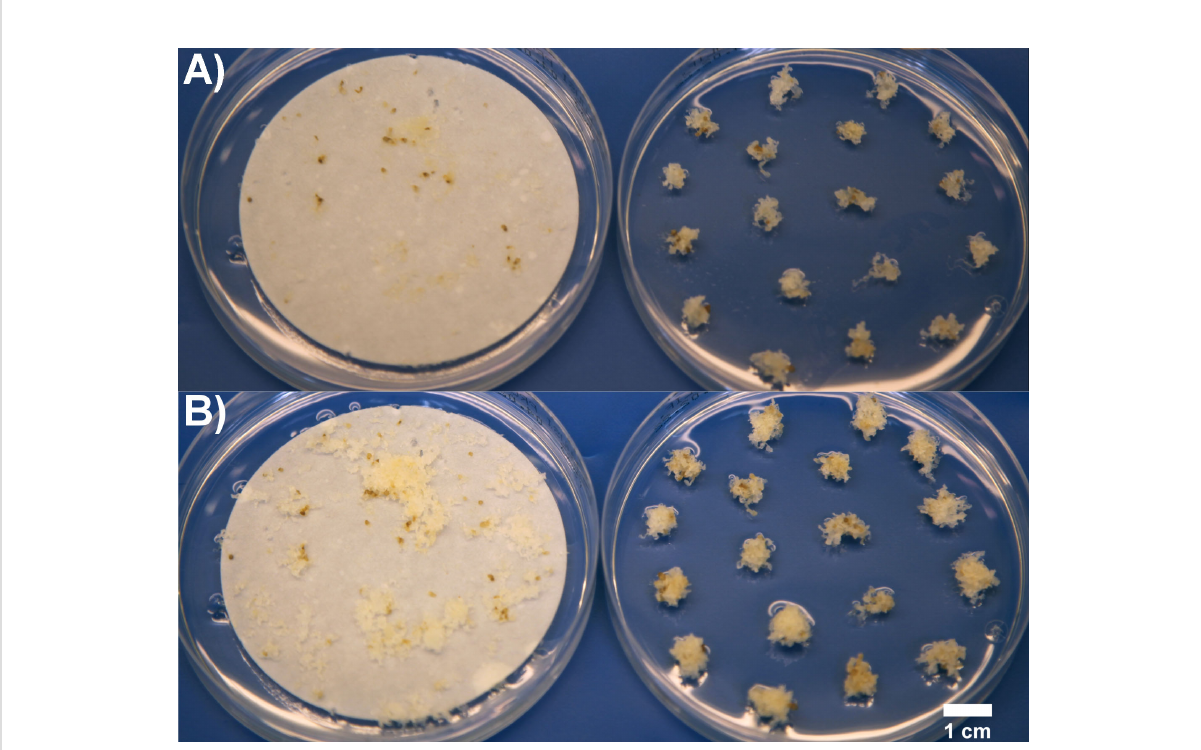
FIGURE 1 ET of line 2891 immediately after subculture (A) , and one-week after subculture before transfer to maturation (B) on fi lters (left) and as clumps (right) in Trial